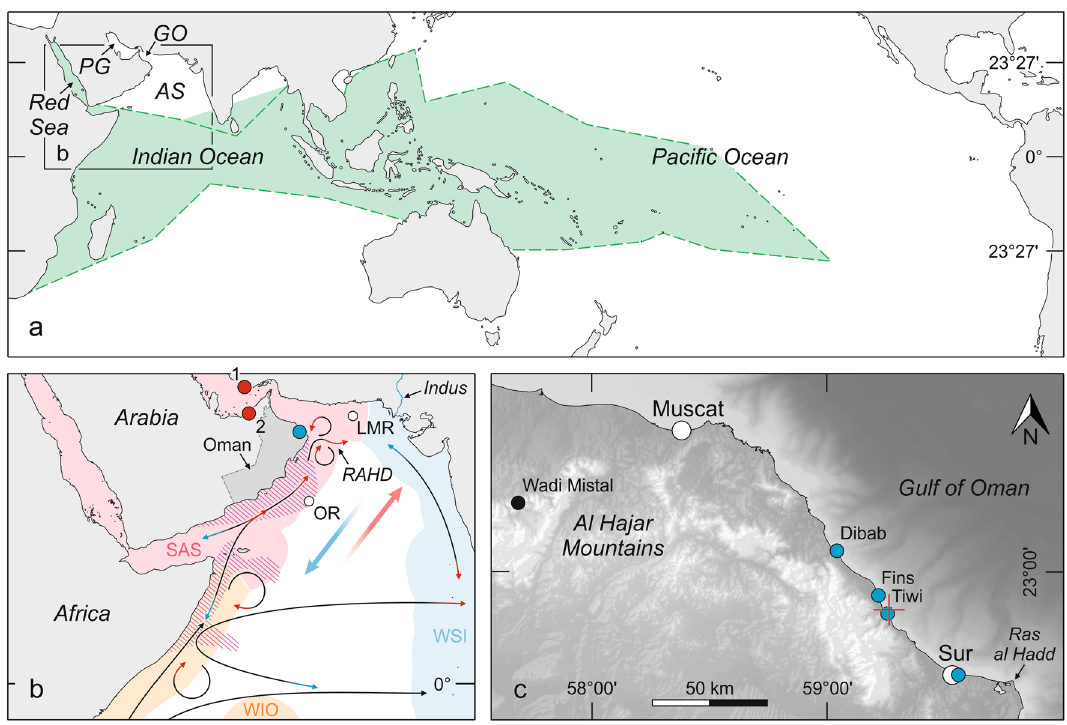
Figure 1. Giant clam biogeography and study area. ( a ) Present-day geographical distribution of the Tridacninae (green area) and Tridacna maxima (dashed green line) in the Indo-West Pacific region 5 ( AS Arabian Sea, GO Gulf of Oman, PG Persian Gulf). ( b ) Detailed map indicating last interglacial (red dots) and last glacial (blue dot) Tridacna occurrences in the Persian Gulf (1: Kish Island 22 , 2: Abu Dhabi 7 ) and Gulf of Oman, and recent coral biogeographic provinces of the western Indian Ocean ( WIO Western Indian Ocean Province, SAS Somali- Arabian Seas Province, WSI West and South India Province) 8 . Seasonal wind directions are shown by red (SWM, summer) and blue (NEM, winter) large arrows. The surface circulation in the Arabian Sea is indicated by thin arrows ( RAHD Ras al Hadd oceanic dipole). Seasonally reversing currents are marked by red (SWM) and blue (NEM) arrowheads. Coastal upwelling zones during the SWM season are highlighted by purple hatching. White dots indicate the locations of SWM multi-proxy stacks ( OR Owen Ridge 48 , LMR Little Murray Ridge 49 ). ( c ) Bathymetric and topographic map of northeastern Oman (GEBCO 2020 bathymetric data, https:// www. gebco. net) showing the locations of fossil Tridacna sites considered in this study (blue dots), the measurement location (red cross) of recent SST data (Supplementary Fig. S3), and the location of the fluvio-lacustrine record of MIS3 precipitation pattern from Wadi Mistal 29 (black dot). The maps were created using the CoralDraw Graphics Suite 2017 (https:// www. corel draw. com) and QGIS 2.18.15 (https:// www. qgis. org)